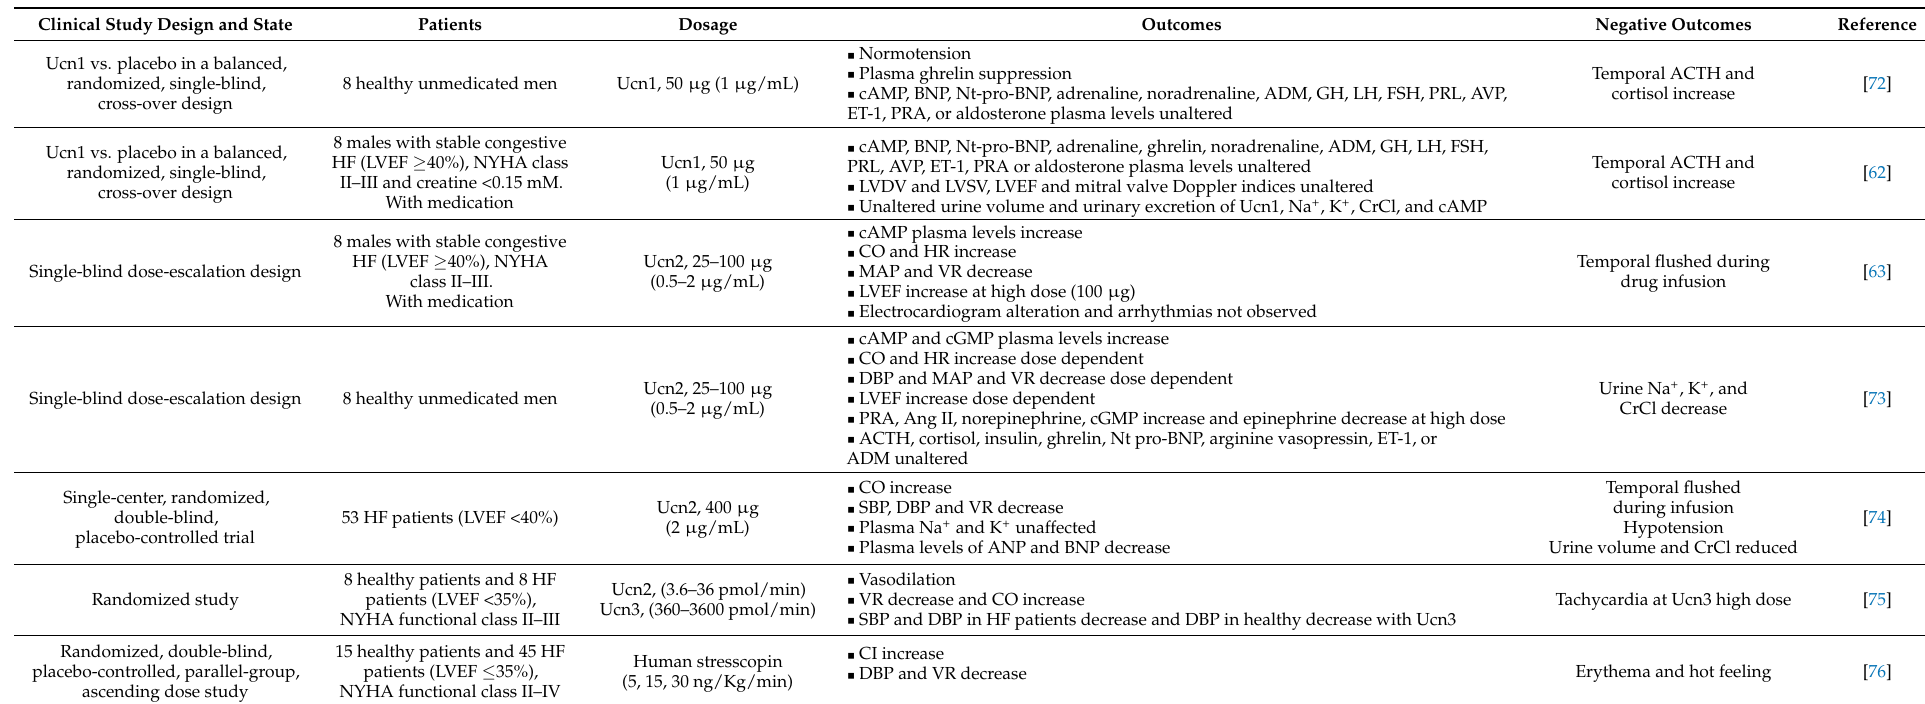
Abbreviations: ACTH, adrenocorticotropic hormone; ADM, adrenomedullin; ANP, atrial natriuretic peptide; AngII, angio-